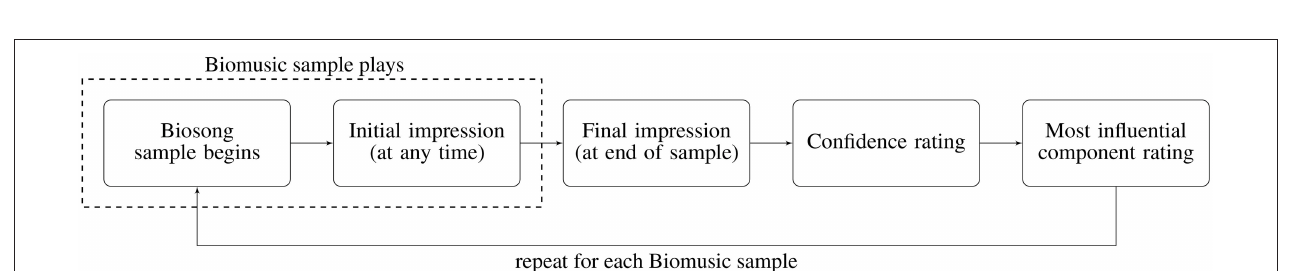
FIGURE 1 | Physiological signal acquisition procedure in Experiment 1.